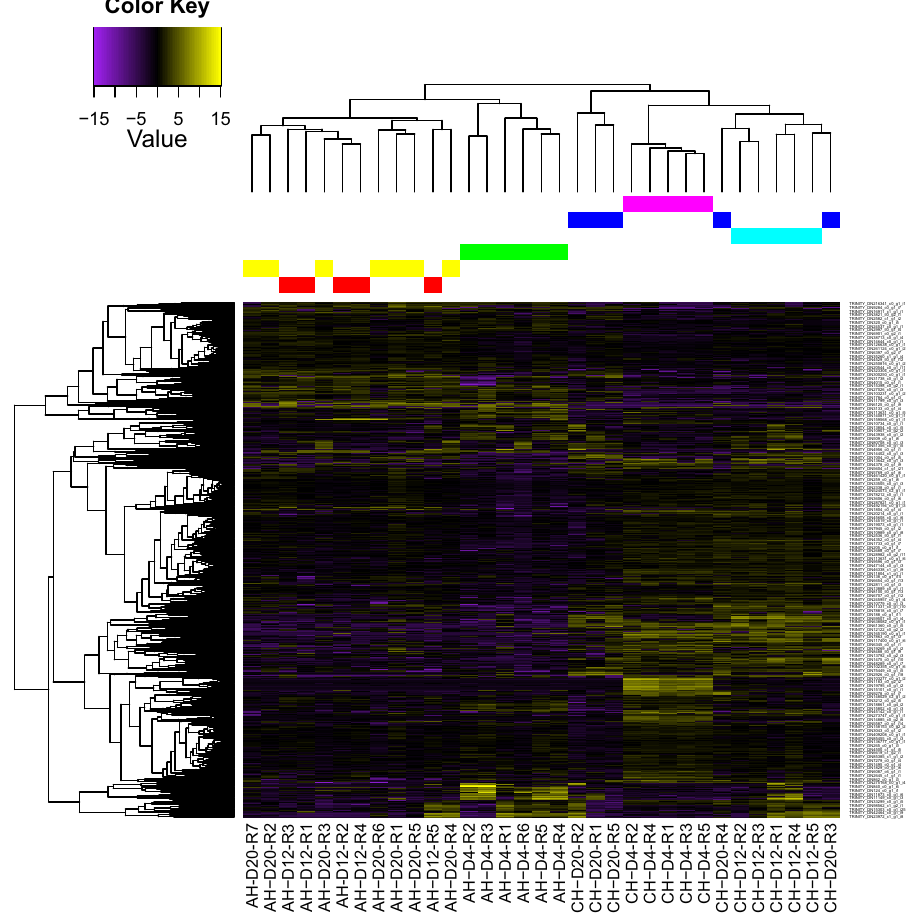
Figure 3. Heat map showing the DETs between axenic and conventional larvae. AH and CH refer respectively to axenic and conventional condition, for each time points (D4: day 4, D12: day 12 and D20: day 20), and the R indicates the replicate number. Transcripts with DE values of log2FC > 1 with adjusted p -value < 0.01 were clustered together based on expression pattern, as represented by the dendrogram at the top of the figure, each color coding for each combination of condition and time (yellow = Axenic day 20; red = Axenic day 12; green = Axenic day 4; dark blue = Conventional day 20, purple = Conventional day 4, blue = Conventional day 12). Presented values are for unique DETs arbitrarily named with Trinity (on the right). Measured phylogeny of transcripts is present on the